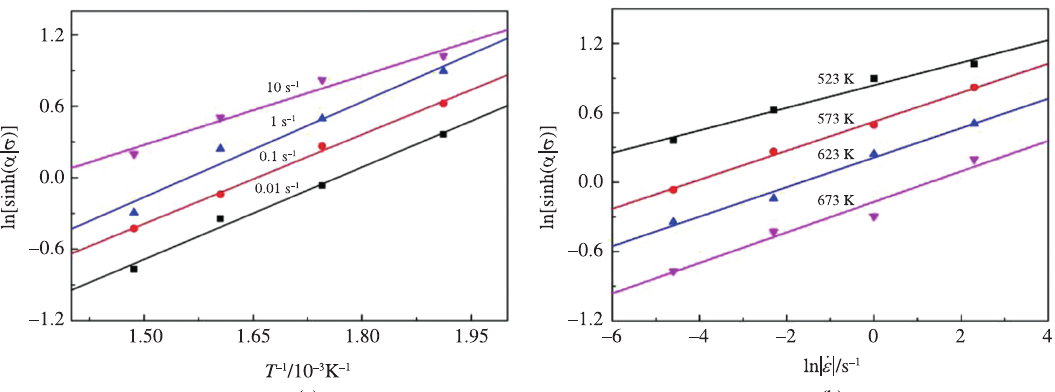
Figure 3. Relationships between: (a) lnsinh[ ] ασ and 1/ T ; (b) lnsinh[ ] ασ and ln  ε